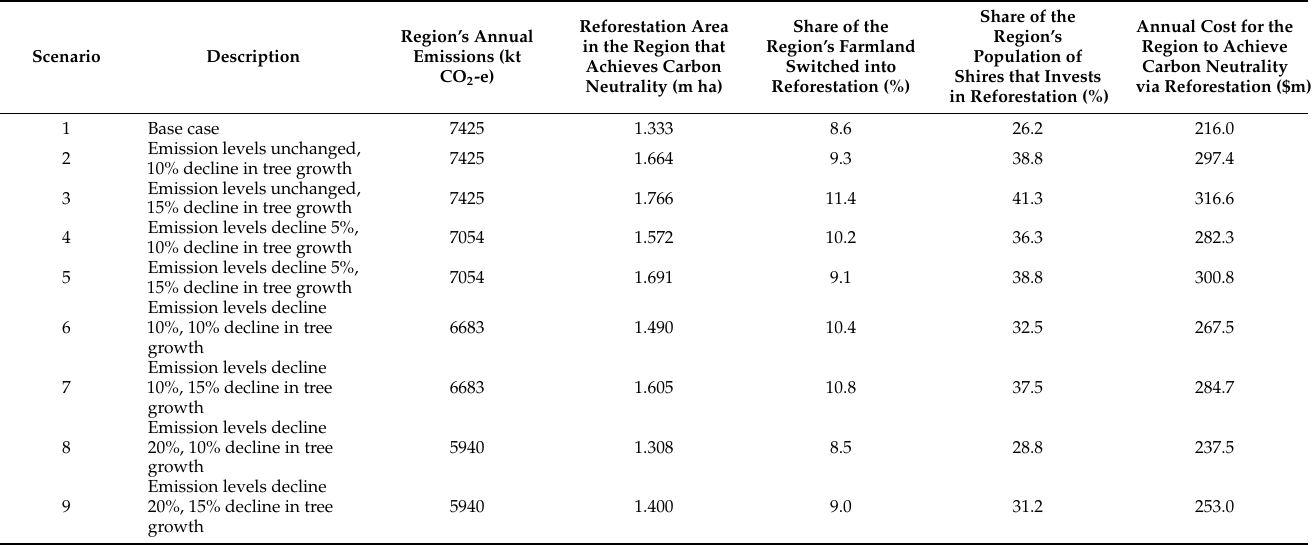
Table 1. Key characteristics of optimal land use in the region to achieve regional carbon neutrality under various scenarios.